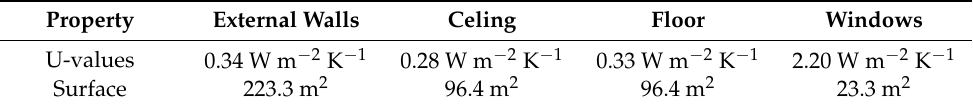
Table 1. U-values (W m − 2 K − 1 ) and surface (m 2 ) for each part of the building envelope. Developed from